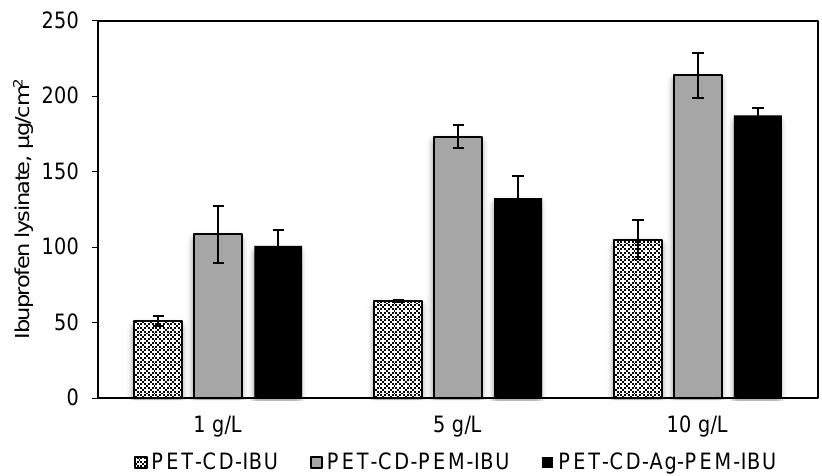
Figure 6. IBU-L adsorbed onto PET-CD, PET-CD-PEM and PET-CD-Ag-PEM dressings. Samples were impregnated in 3 concentrations of IBU-L solutions (1, 5 and 10 g/L) overnight. The assay was carried out by HPLC-UV.